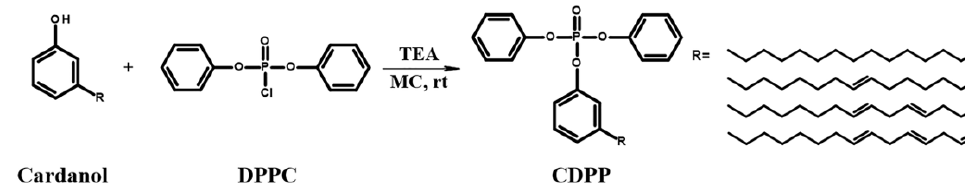
Figure 1. Synthesis route of